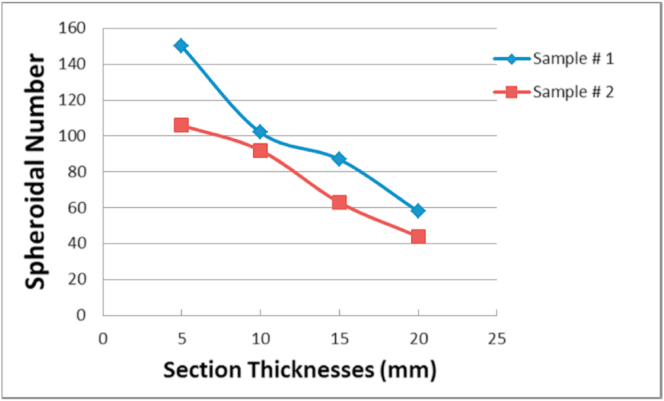
Section thicknesses vs. spheroidal number for the two samples.